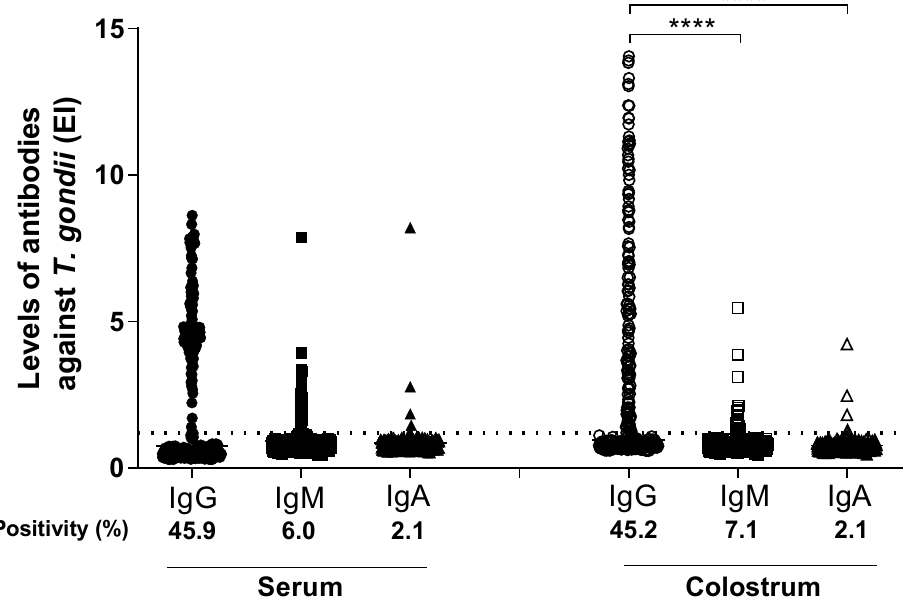
Figure 1. Levels of IgG, IgM, and IgA antibodies against T. gondii . Data determined by ELISA index (EI), in paired samples of serum and colostrum of postpartum women ( n = 283). The solid lines represent the median values of the IE for each reaction and the dashed line the cut-off value (EI = 1.2). Differences between EI levels were calculated by Dunn’s multiple comparison test (**** p <